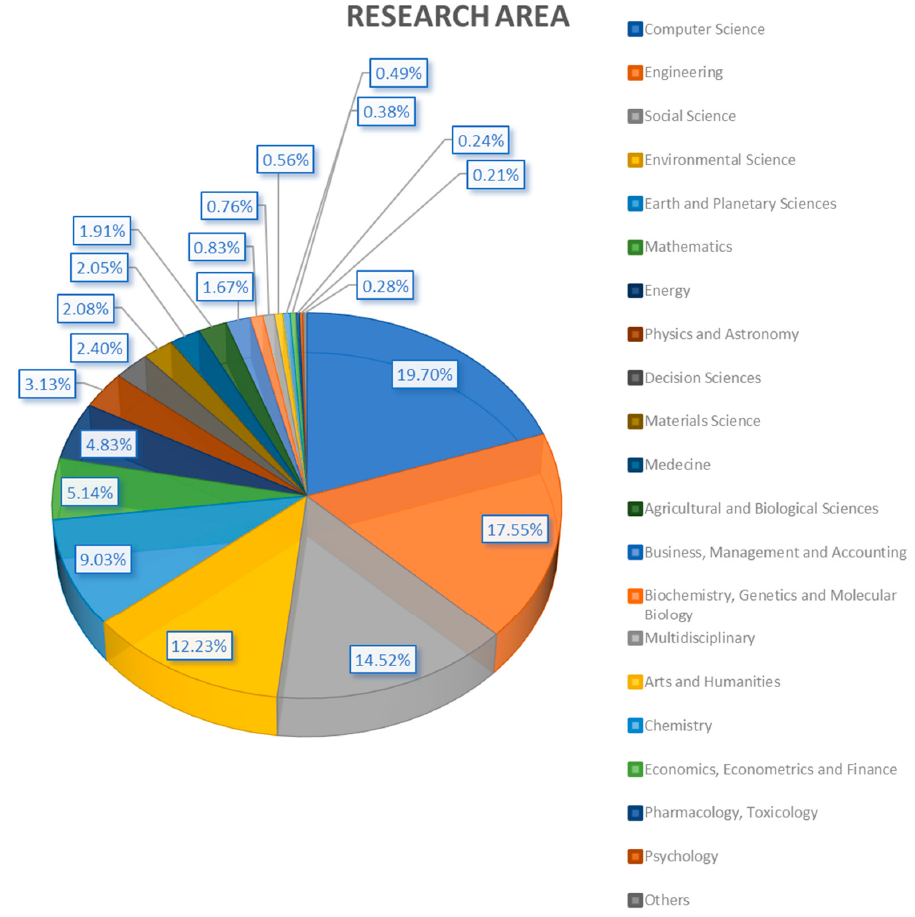
Figure 2. Machine learning on research areas (database: Scopus, authors’ elaboration).